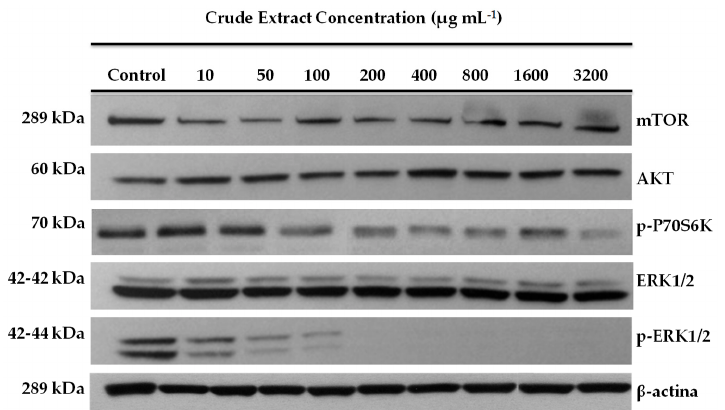
Figure 3. Effect of aqueous crude leaf extracts of blueberry plants treated with MeJA on the expression of gastric cancer-related protein in the AGS cell line. The inhibitory effect on protein expression of of gastric cancer-related protein in the AGS cell line. The inhibitory e ff ect on protein expression of AKT/mTOR pathway was assessed by Western blot and 35–40 µg of protein was loaded in each well. AKT / mTOR pathway was assessed by Western blot and 35–40 µ g of protein was loaded in each well. The β -actin (45 kDa) was used as an internal loading control. The β -actin (45 kDa) was used as an internal loading